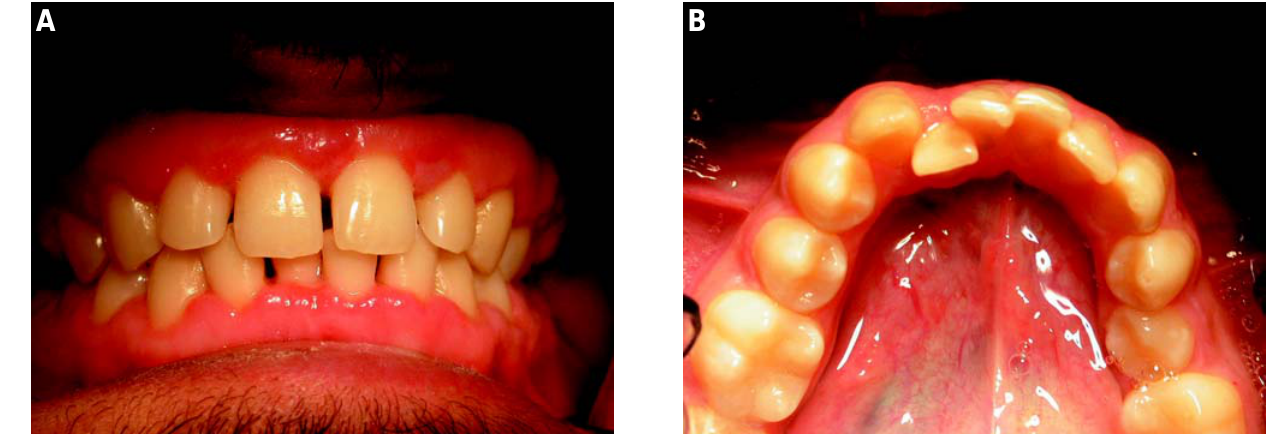
FIGURE 2- Gingivectomy performed at the buccal (A) and lingual (B) surfaces